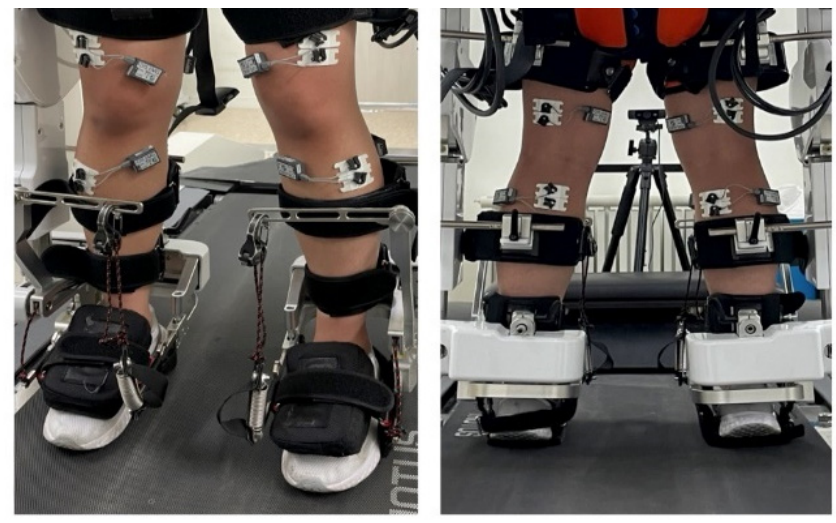
Figure 2. EMG electrode placement. Anterior view ( left ) and posterior view ( right ).